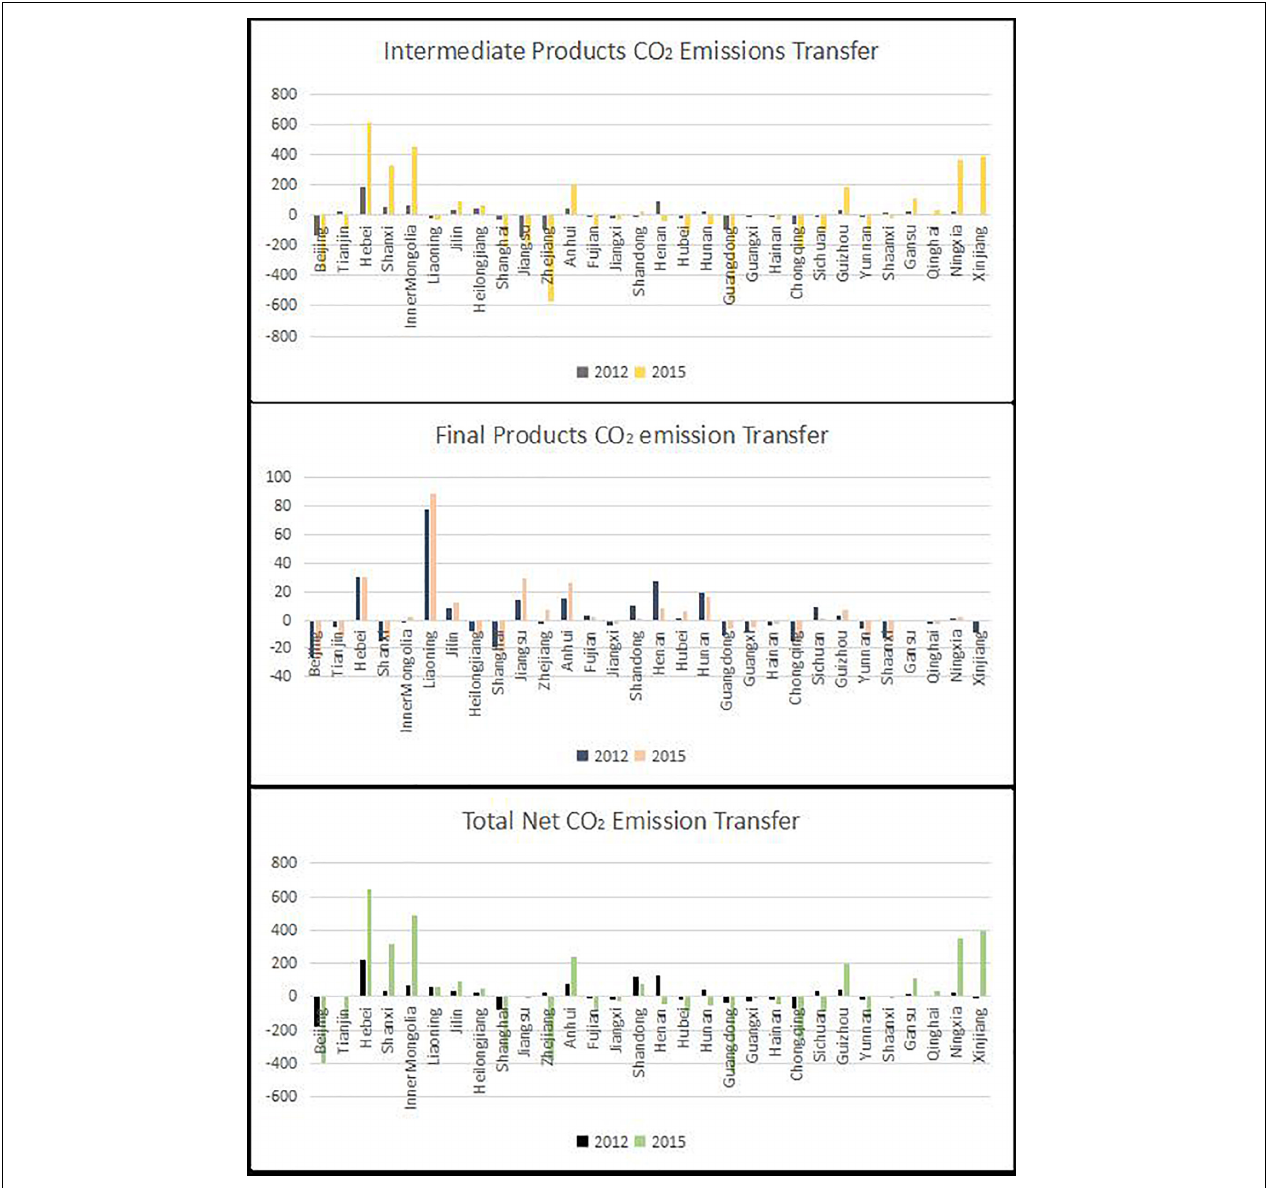
FIGURE 3 | Details of CO 2 transfer in 2012 and